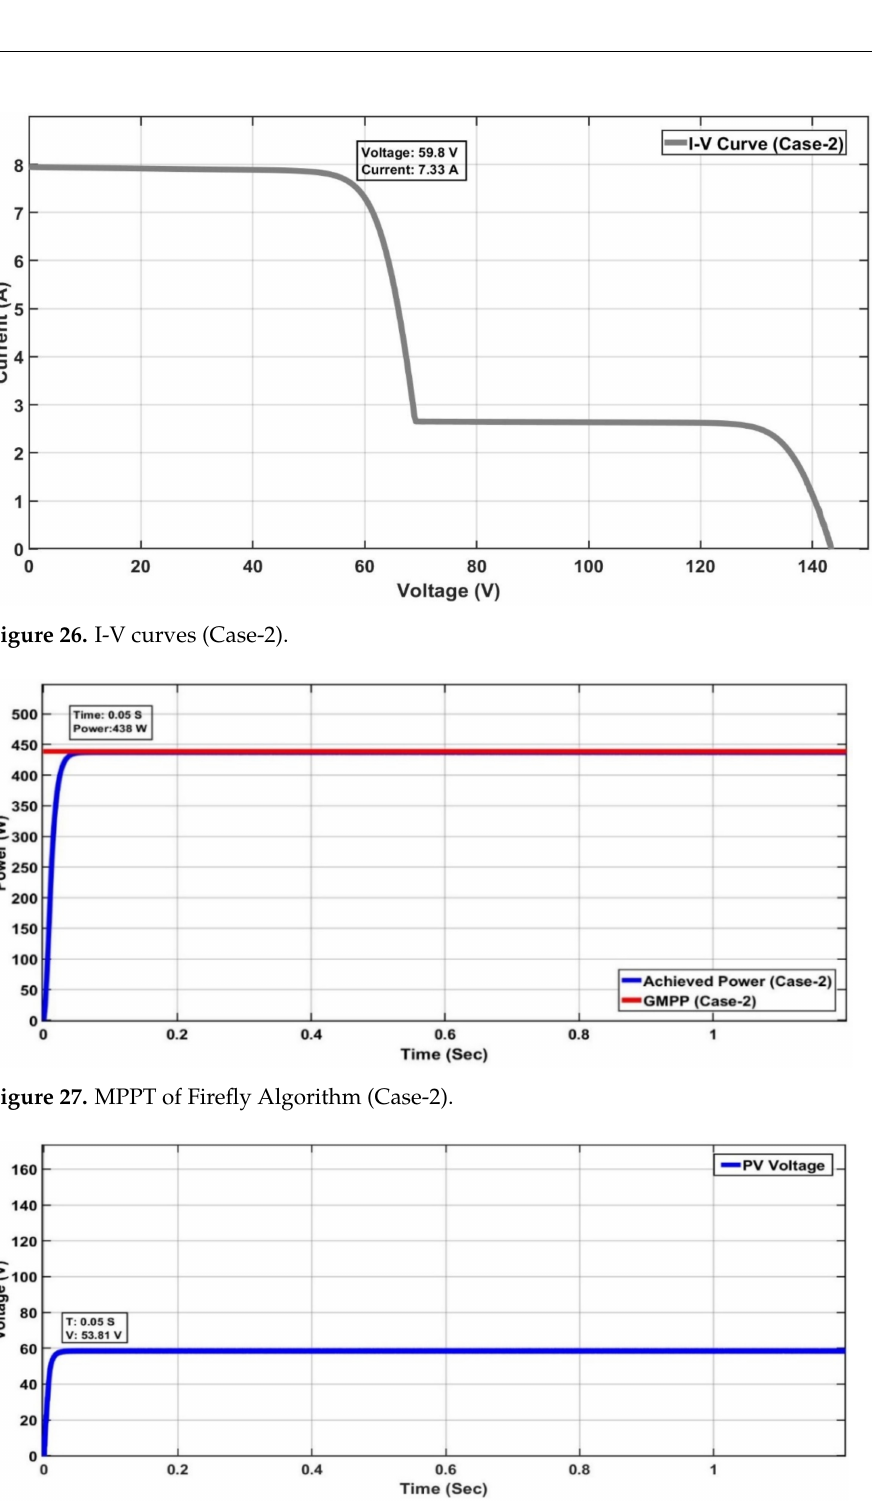
Figure 28. V pv of Firefly Algorithm